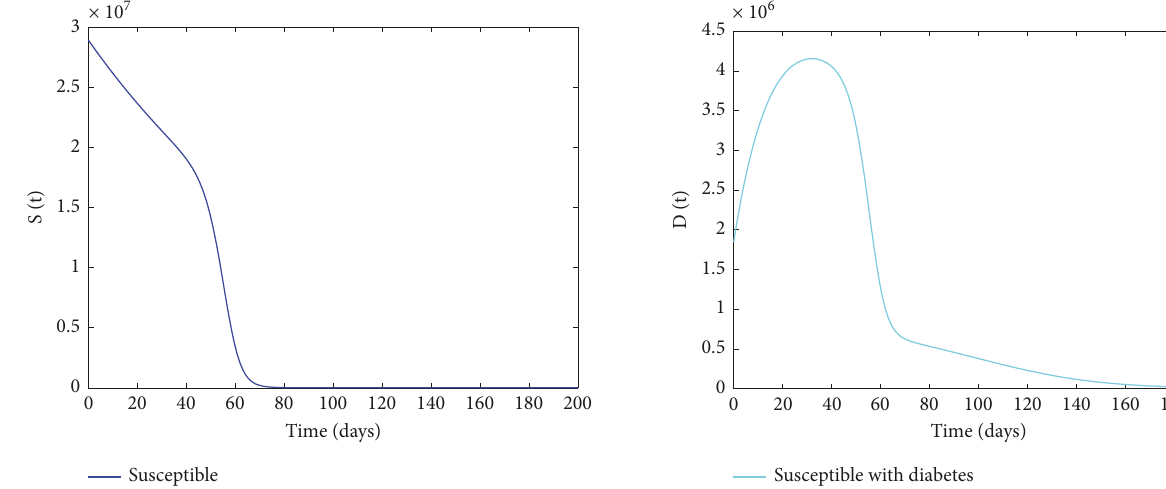
Figure 7: Behaviour of the susceptible with diabetes.